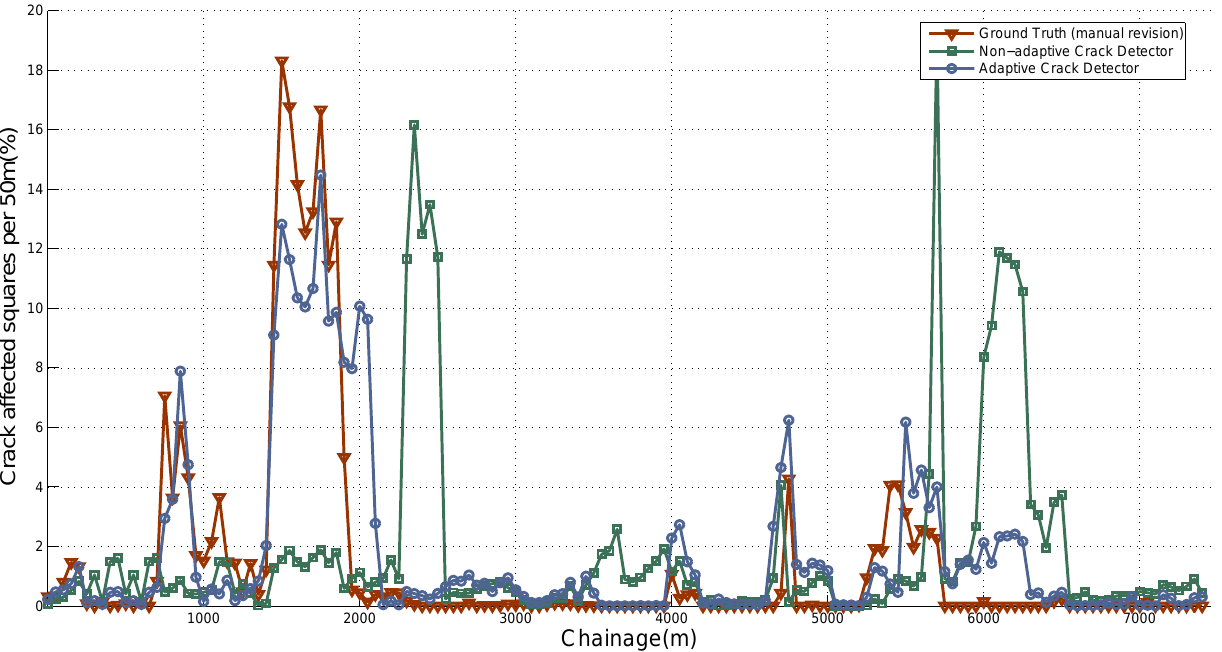
Figure 22. Computed percentage of each 50 m subsection of road affected by cracking. Comparison between the ground truth, crack detection system and adaptive crack detection system.